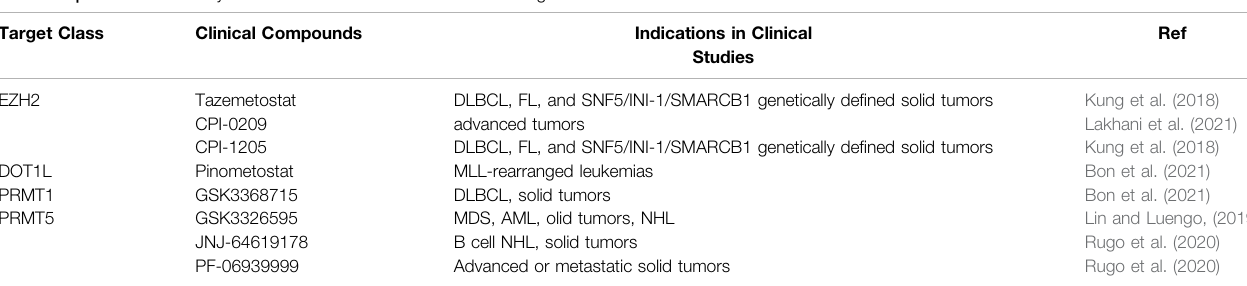
TABLE 2 | Overview of methyltransferase inhibitors under clinical